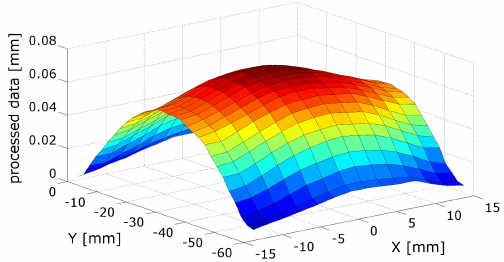
Figure 9. Cooling of